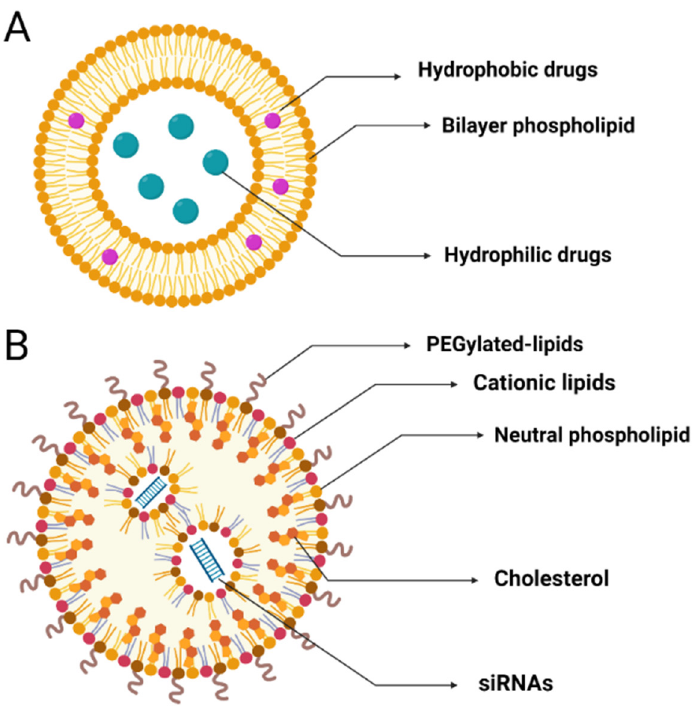
Figure 3. Structures of liposomes and cationic LNPs. ( A ) Liposomes: small-molecule artificial vesicles with a hydrophobic phospholipid double layer outside and a hydrophilic core inside. ( B ) Cationic LNPs: spherical particles composed of ionizable cationic lipids, cholesterol, phospholipids, and PEGylated lipids. LNPs, lipid nanoparticles; PEG, polyethylene glycol. Created with BioRen- der.com.